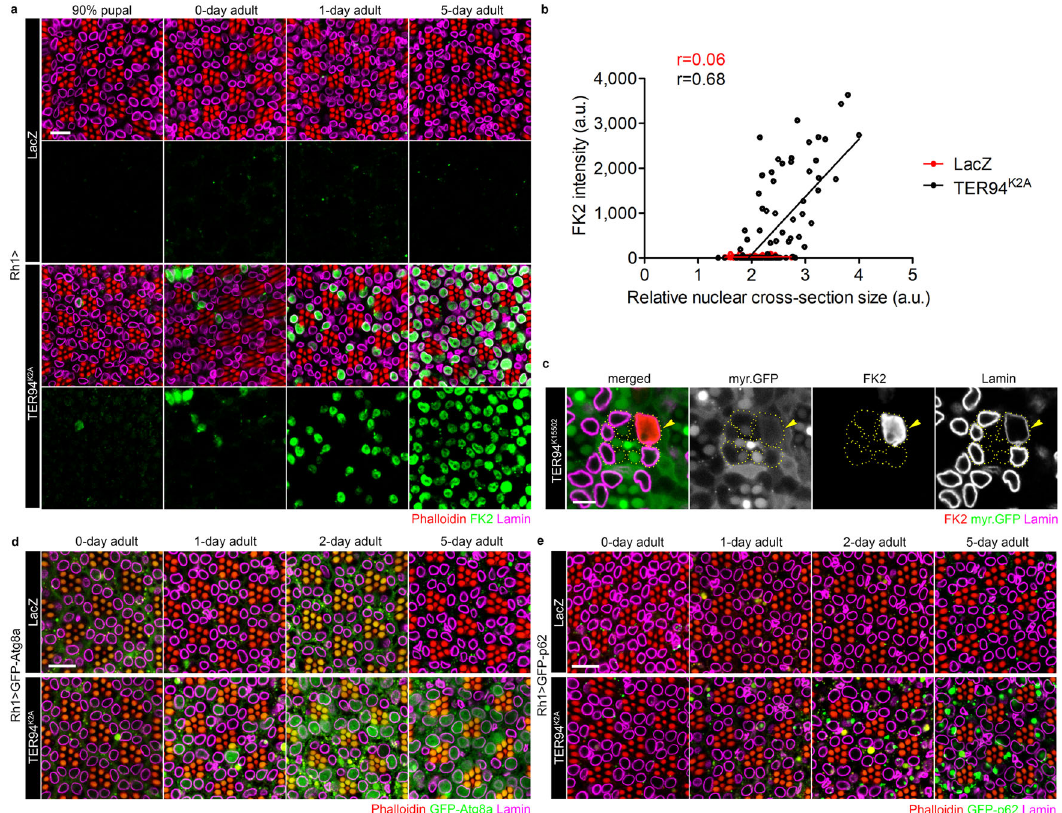
Fig. 2 Atg8, p62, and ubiquitinated nuclear proteins accumulate in cells lacking TER94 function. a Time-course analysis of the nuclear size change and the presence of ubiquitinated proteins in Rh1 > LacZ and Rh1 > TER94 K2A pupal or adult eyes stained with phalloidin (red), anti-Lamin (magenta), and anti- Ubiquitin conjugates (FK2, green) antibodies. b Pearson ’ s correlation analysis of nuclear cross-section size and FK2 intensity from images of 1-day-old adult retina (as shown in panel a ). The number of independent nuclei measured are 88 (LacZ) and 125 (TER94 K2A ). r values represent Pearson ’ s correlation coef fi cient in each group. c An adult TER94 K15502 clone, marked by the absence of myr.GFP (arrowhead), stained with anti-Lamin (magenta) and anti- Ubiquitin conjugates (FK2, red) antibodies. R cell boundaries are outlined in dash lines. d , e Retinas from freshly eclosed (0-day) to 5-day-old adults co- expressing GFP-Atg8a ( d ) or GFP-p62 ( e ) with LacZ (control) or TER94 K2A under the control of Rh1-GAL4 stained with phalloidin (red) and anti-Lamin (magenta) antibody. The number of independent experiments performed: a 2 (LacZ), 5 (TER94 K2A ) for 90% pupal; 3 (LacZ), 2 (TER94 K2A ) for 0-day; 4 (LacZ), 6 (TER94 K2A ) for 1-day; 6 (LacZ), 6 (TER94 K2A ) for 5-day adult. c 6. d 3 (0-day), 2 (1-day), 6 (2-day), 3 (5-day). e 2 (0-day), 5 (1-day), 5